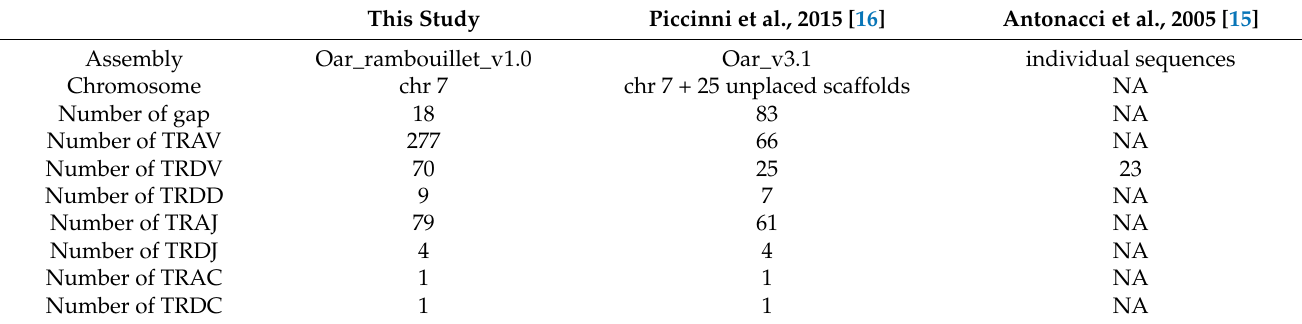
Table 3. Comparison of the different studies of TRA/TRD loci in sheep ( Ovis aries ). This